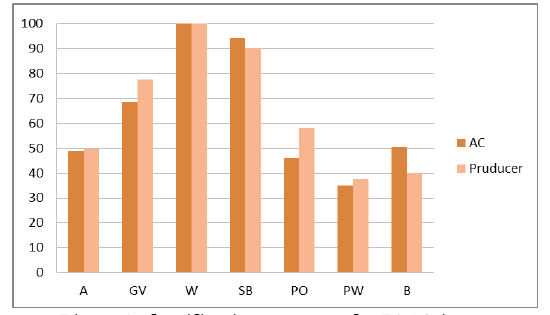
Figure 2 classification accuracy for FQ18